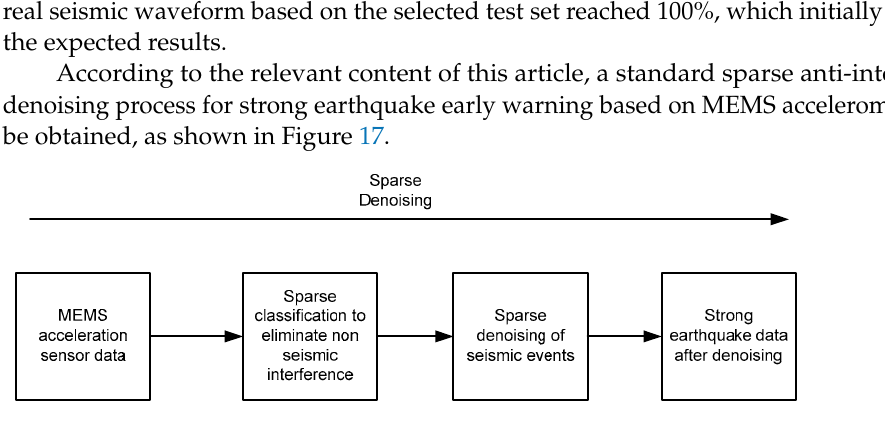
Figure 17. A standard sparse anti-interference denoising processes for strong earthquake early warning based on MEMS accelerometers. warning based on MEMS